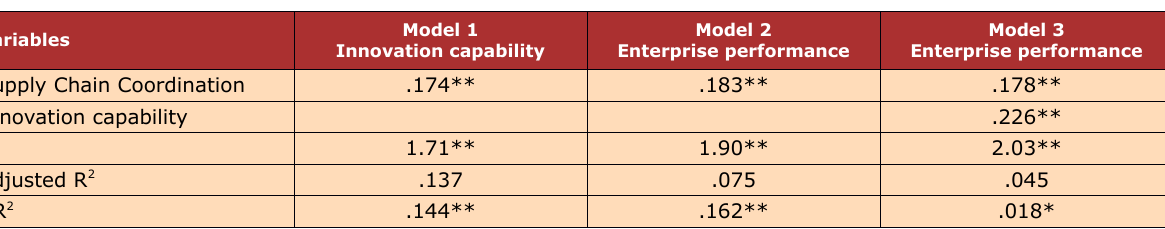
Table 9. Mediation test of Innovation capability between Supply Chain Coordination and Enterprise